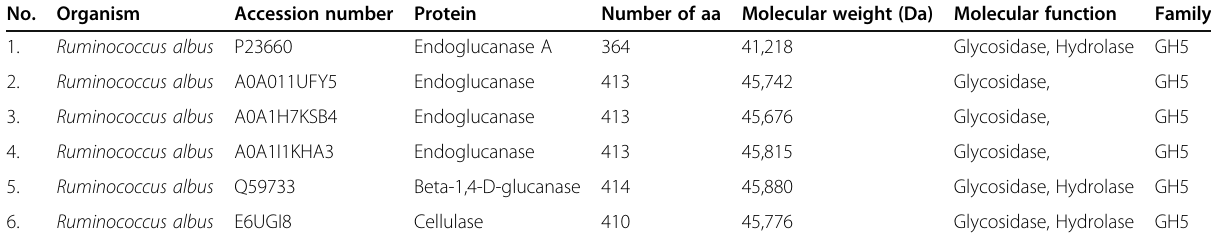
Table 1 Characterization of retrieved sequences of cellulases for different R. albus strains using UniProt tool No.